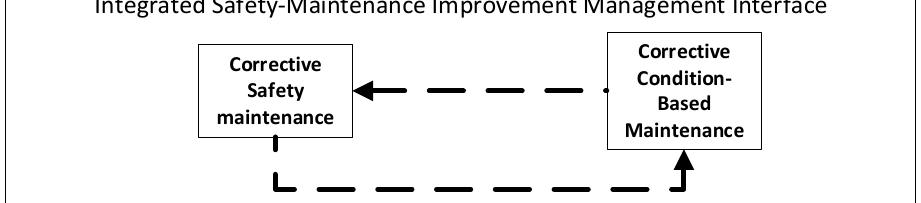
Figure 3. Research phases and methodology. The proposed framework develops a novel risk ‐ informed methodology for the inte ‐ grated safety–maintenance management of public and educational facilities. The frame ‐ work builds upon an integrated tool for combined safety–maintenance monitoring of fa ‐ cilities. The framework takes advantage of the synergy between maintenance and safety and leverages the synergy to introduce enhanced high ‐ performance, safe and cost ‐ effec ‐ tive maintenance of facilities. 4. Research Method The research employed analytical–empirical methods aimed at the development of an integrated maintenance–safety framework and validation of the framework through inferential statistics and a case study. The research followed the definitions of ISO/DIS 45001 [45] and the guidelines of ISO 14001 and OSH 2001: Guidelines on Occupational Safety and Health Management Systems. The research phases and method are described in Figure 3. It followed five steps [19,46,47]: (1) data gathering methodology for safety and maintenance assessment and control in educational and public facilities, (2) field survey of maintenance and safety in educational facilities, (3) inferential statistical analysis and the development of an integrated risk ‐ informed safety–maintenance framework, (4) im ‐ plementation and validation of the framework in a public facility case study and assess ‐ ment of the research hypothesis using regression analysis and F ‐ statistics and (5) conclu ‐ sion and recommendations for further research. The framework is a theoretical and prac ‐ tical framework, and the theory is validated in a field survey in Section 3 and implemented for practical validation in Section 4. The research employed four tools of data gathering and analysis: